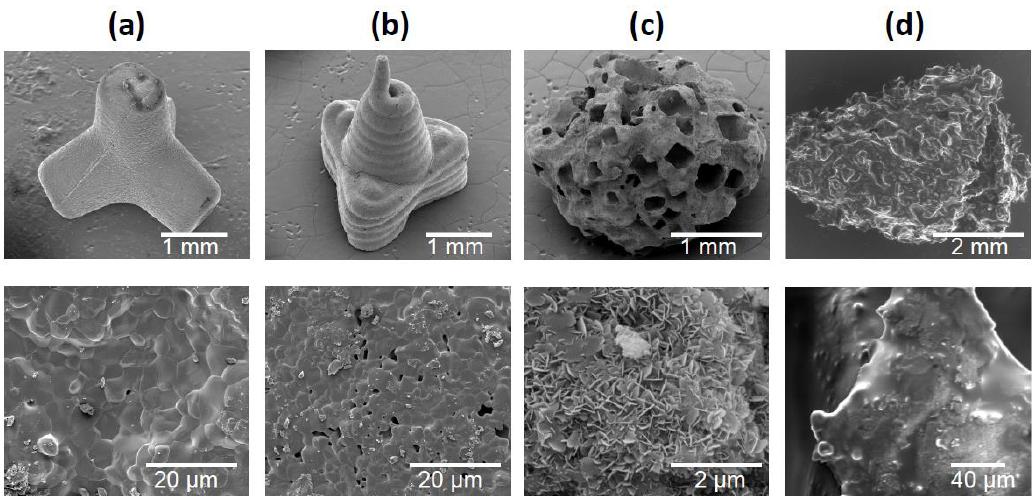
Figure 2. Scanning electron micrographs of granules and bone chips used in this study. ( a ) Tetrapods, ( b ) pyramids, ( c ) Calcibon granules, and ( d ) morselized bone chips.